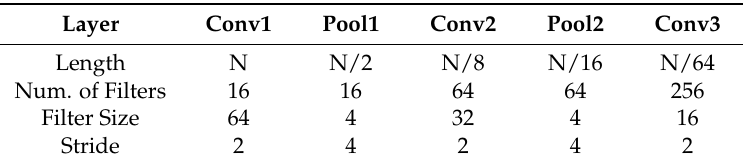
Table 1. The Structure of Convolutional